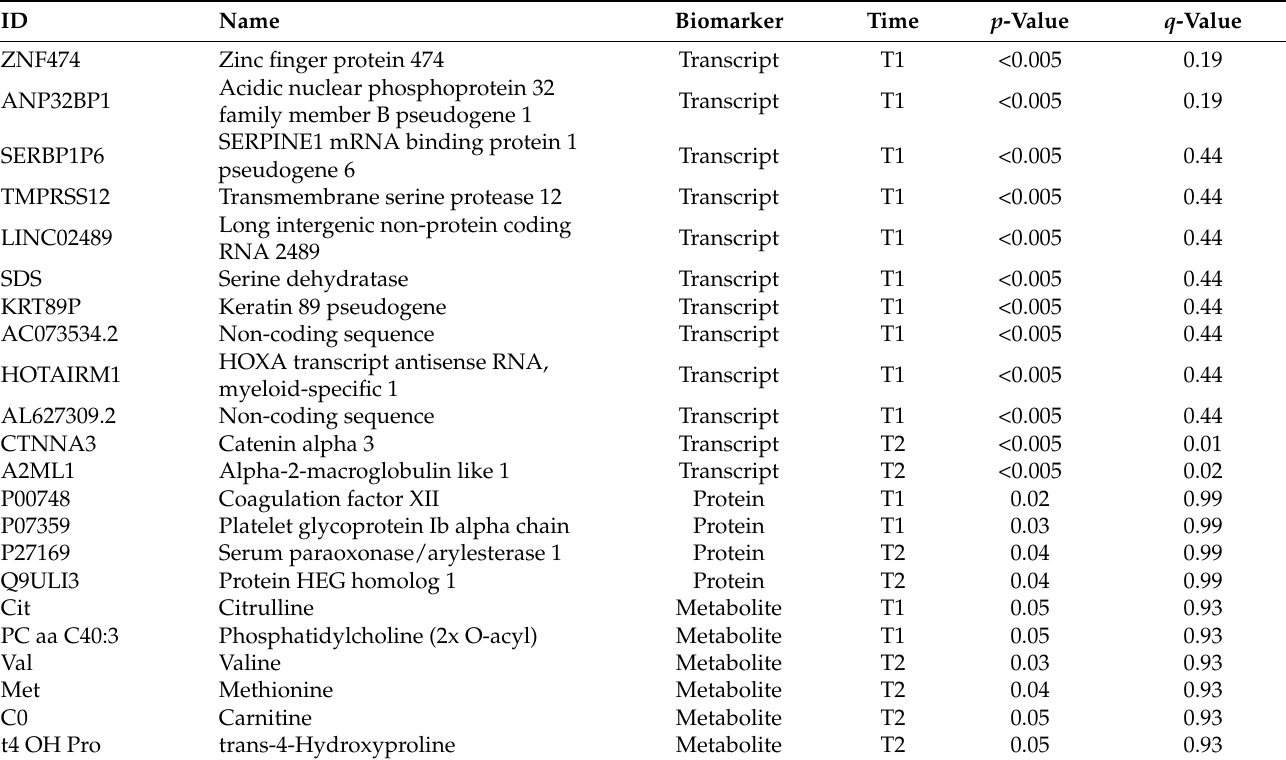
Table 4. One-way ANOVA for the biomarkers related to cardiac dysfunction in patients presenting myocardial injury